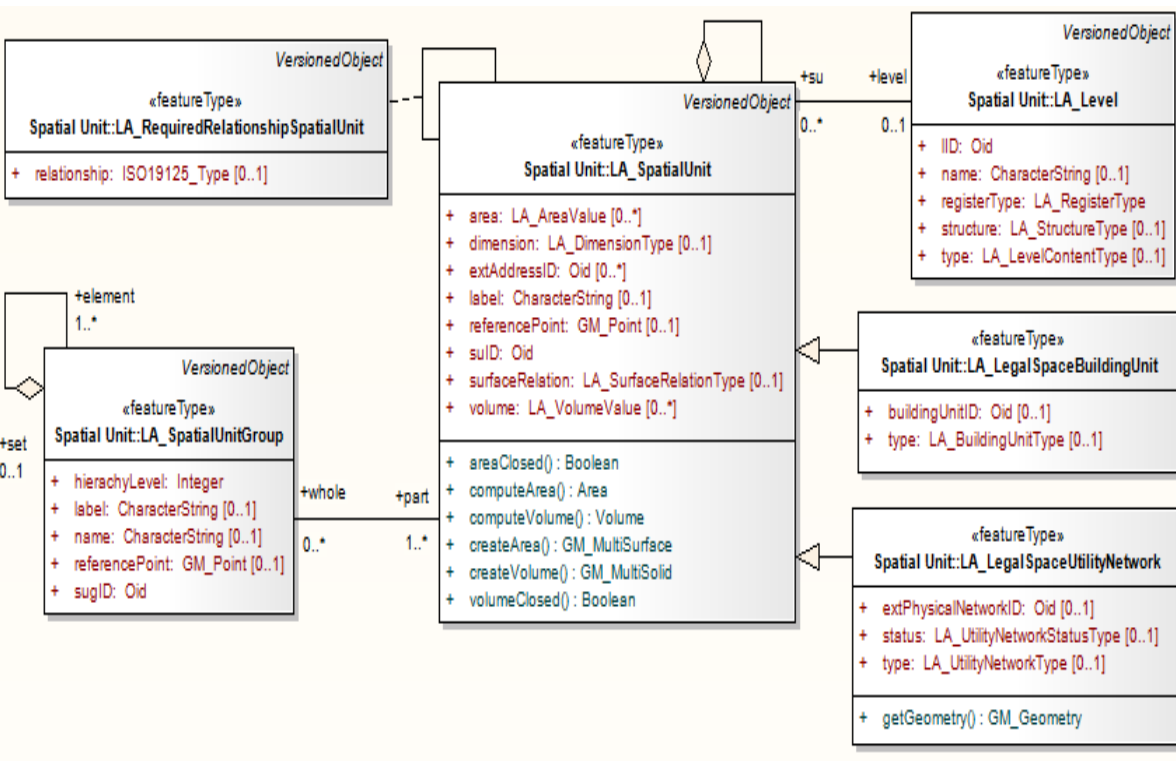
Figure 5. Spatial unit package classes (ISO,